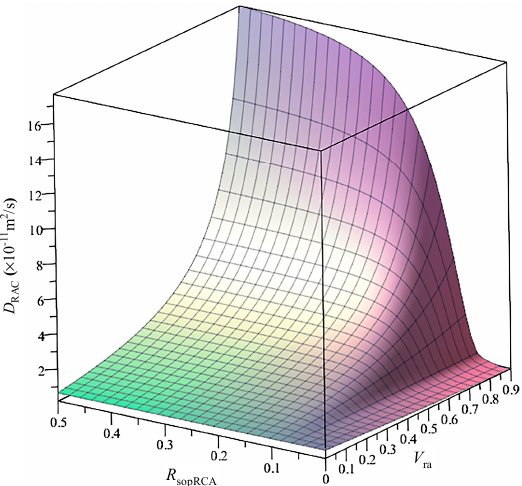
Figure 12. D RAC ( ×10 − 11 m 2 /s) varying with water absorption and volume fractions of RCA. Table 3. The D RAC ( ×10 − 11 m 2 /s) corresponding to Figure 12.